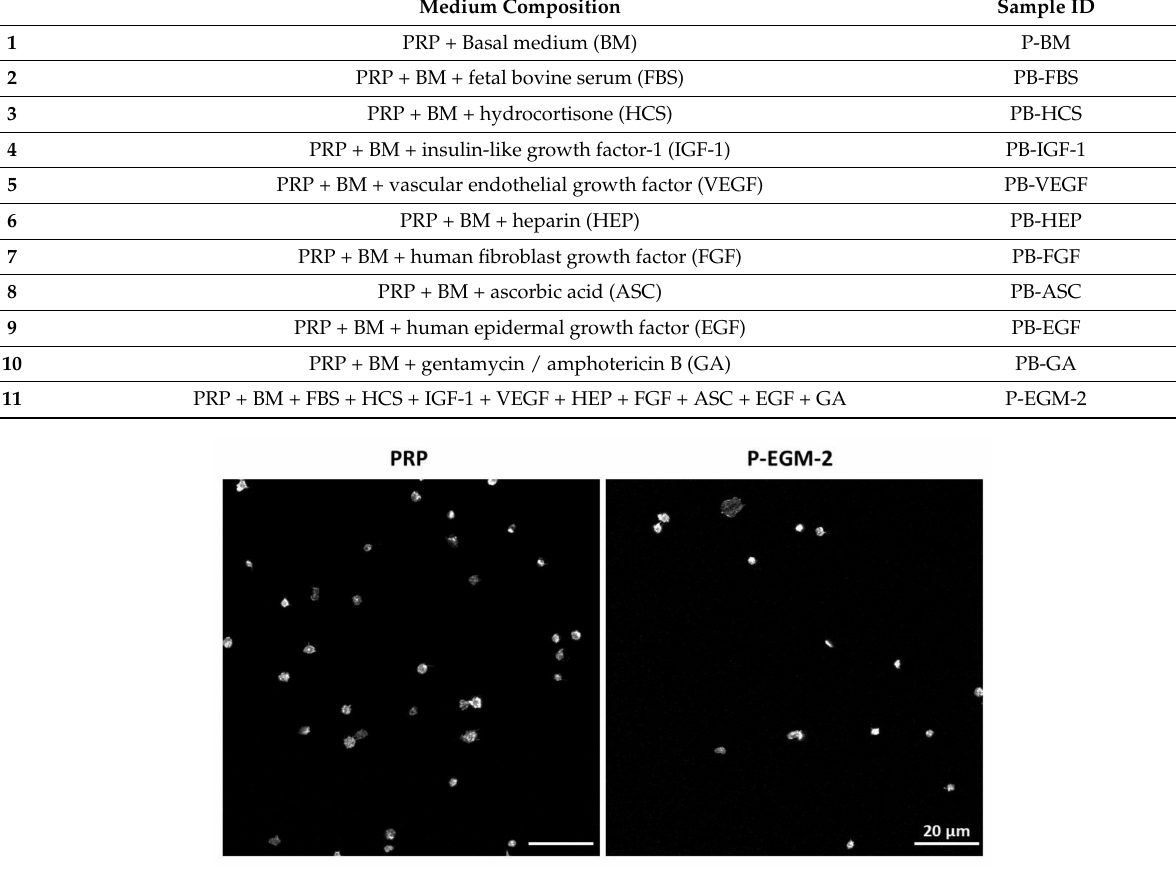
Table 1. Compositions of endothelial cell culture media mixed with platelet-rich plasma (PRP). Medium Composition Sample ID